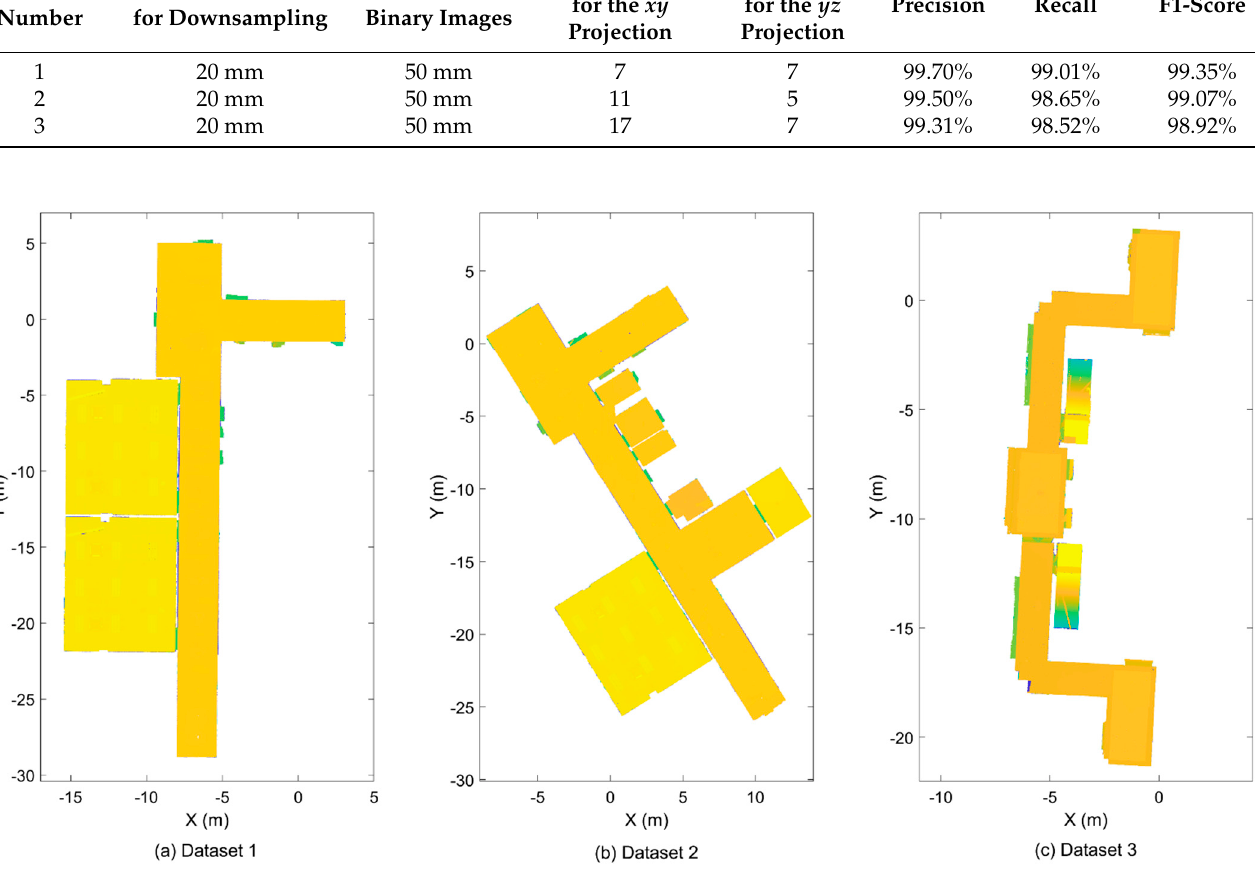
Figure 8. The plan views of the indoor point cloud data selected for the three datasets considered: ( a ) dataset 1, ( b ) dataset 2, and ( c ) dataset 3.